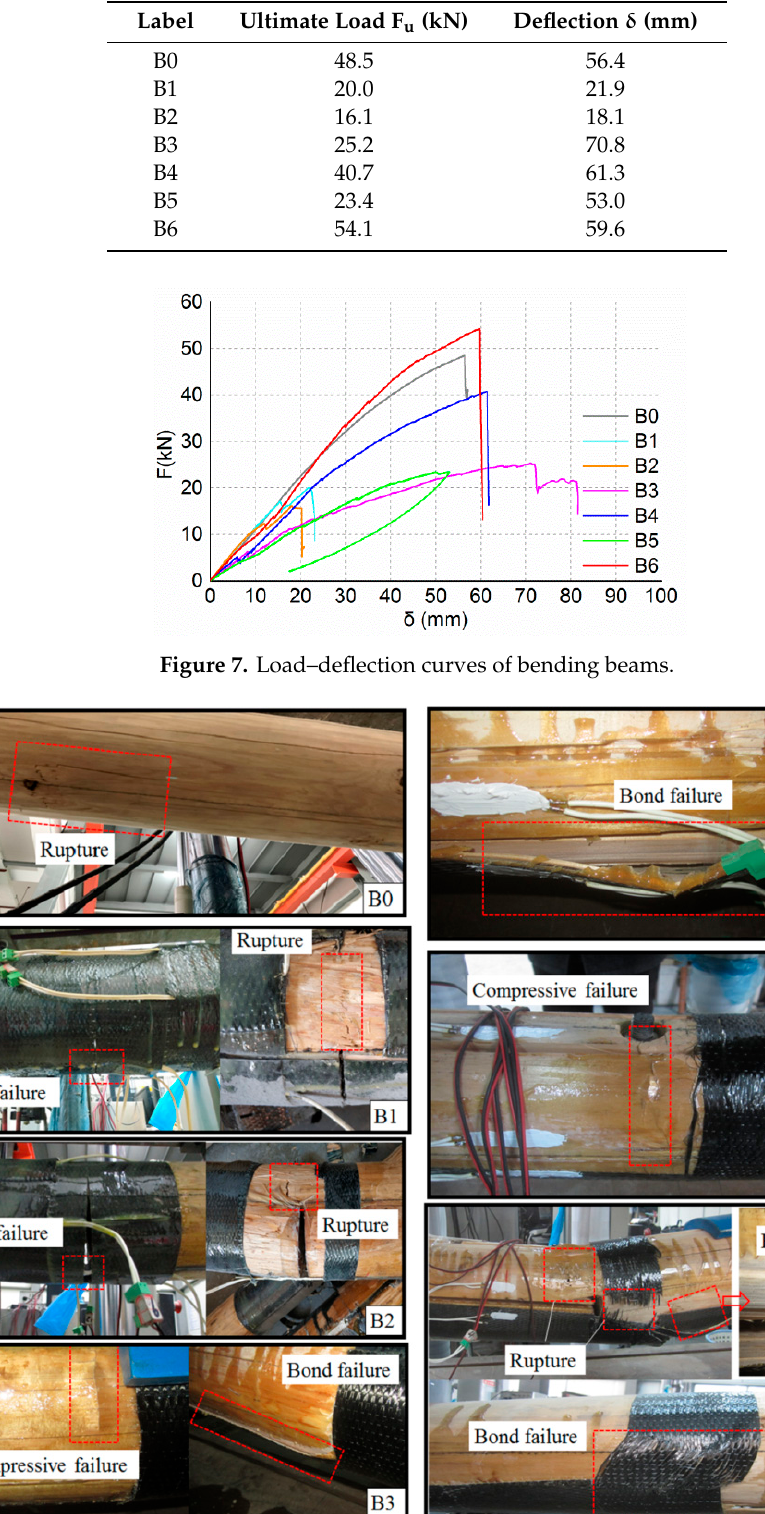
Figure 8. Failure modes of bending beams.